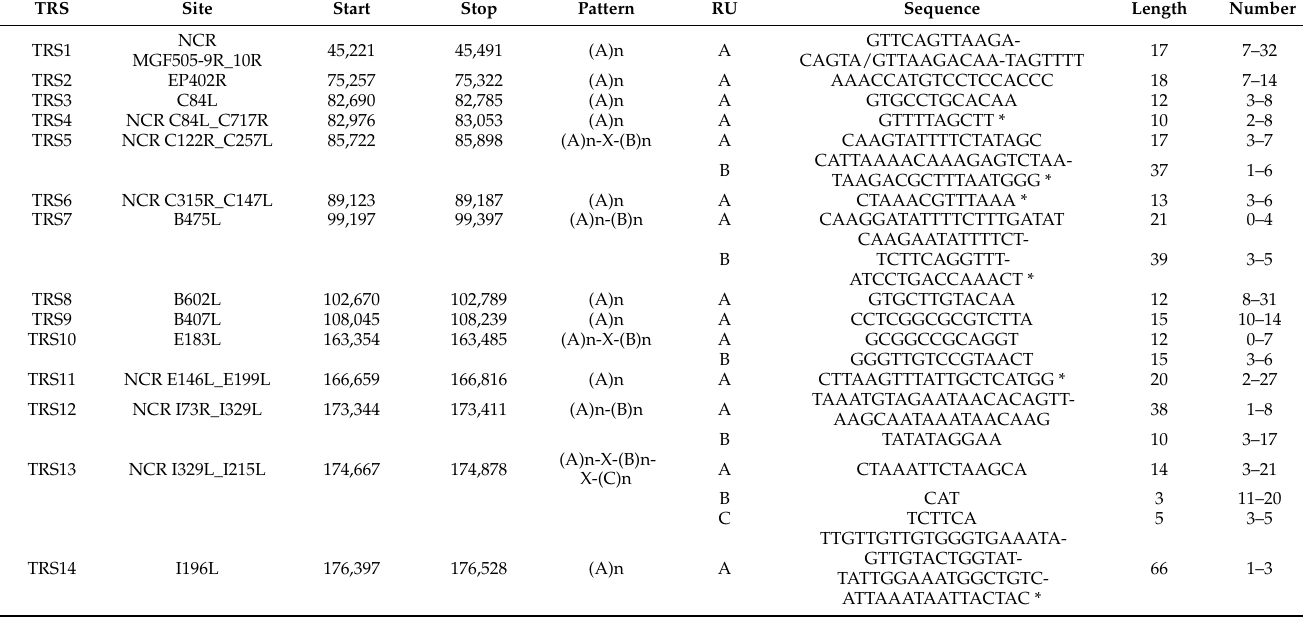
Table 2. Distribution of 14 common tandem repeat sequences (TRS) in the ASFV